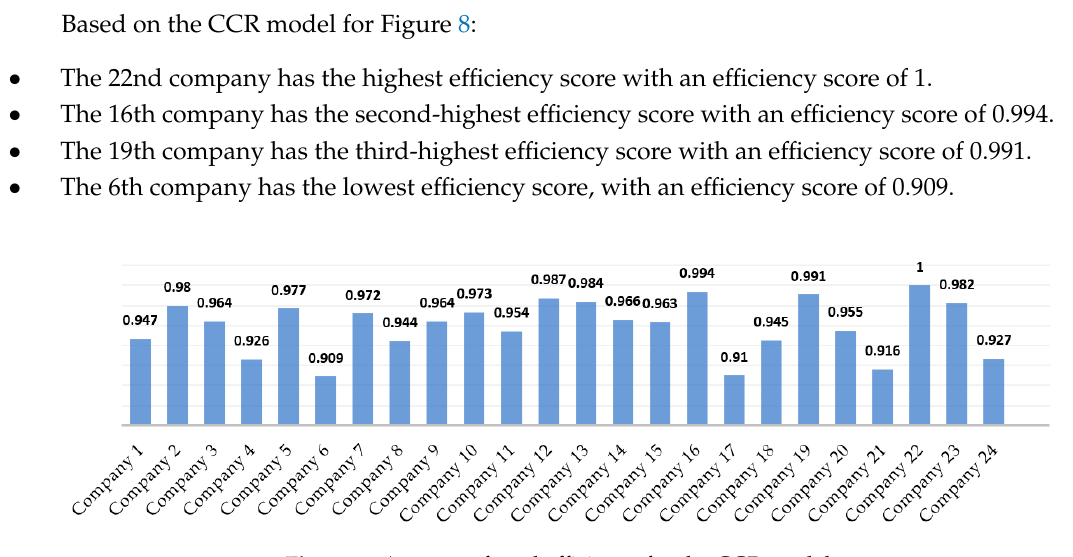
Table 12. Average of windows in the CCR model for each three years.